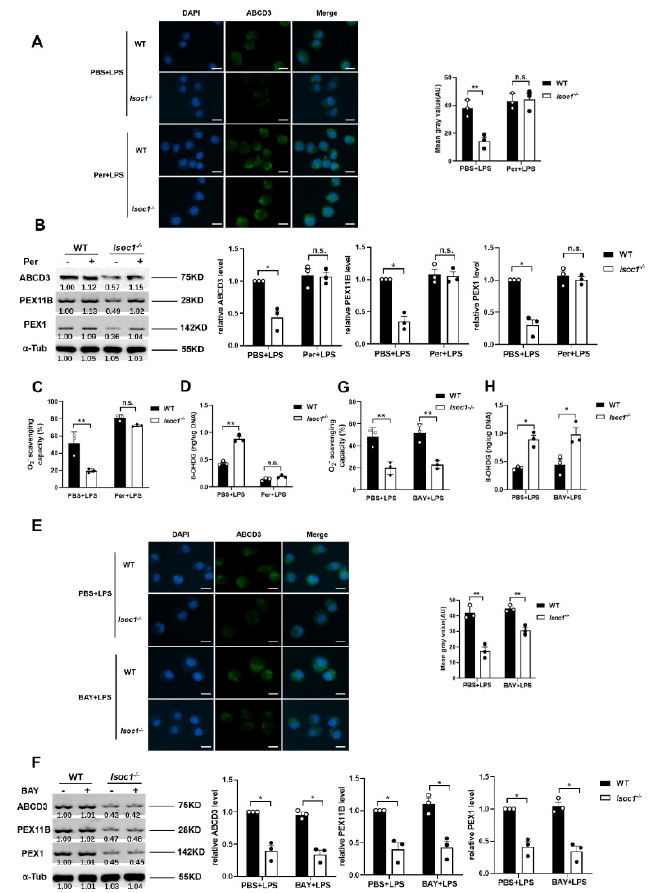
Figure 4. ISOC1 affects peroxisomes through the AKT1 pathway but not the NF- κ B pathway. Wild- type or ISOC1-deficient RAW264.7 were pretreated with 10 µ M Perifosine for 12 h or 10 µ M BAY 11-7082 for 1.5 h, stimulated with 300 ng/mL LPS for 24 h. ( A , E ) Peroxisomes were labeled with ABCD3 and were observed with fluorescence microscopy. Scale bar = 10 µ m. Mean gray value were analyzed by Image J. ( B , F ) WB was used to detect the expression levels of ABCD3, PEX11B, and PEX1. ( C , G ) O2 − scavenging capacity was measured using a superoxide anion scavenging capacity assay Kit. ( D , H ) The content of 8-OHDG was analyzed by an oxidative RNA Damage ELISA Kit. All data are shown as mean ± s.e.m ( n = 3). * p < 0.05, ** p < 0.01, n.s. not significant. Two-way